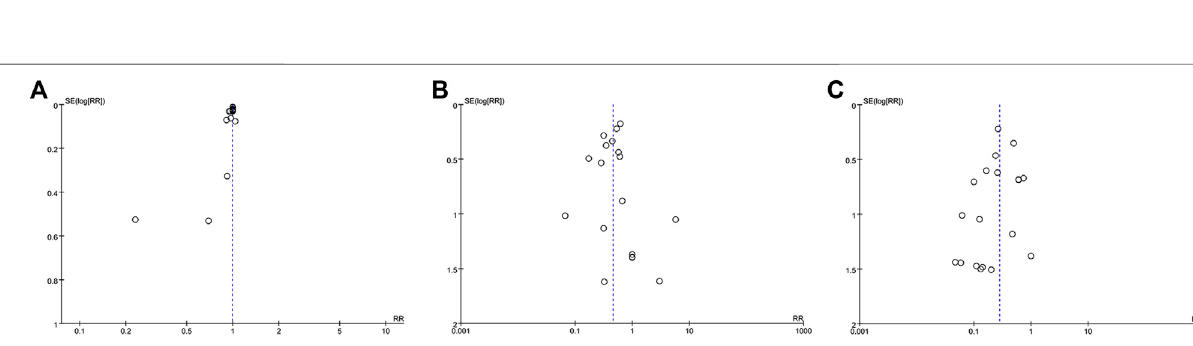
Frontiers in Pharmacology |